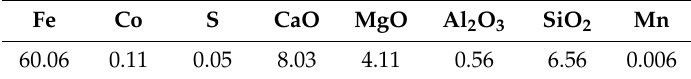
Table 9. Main chemical composition of iron concentrate